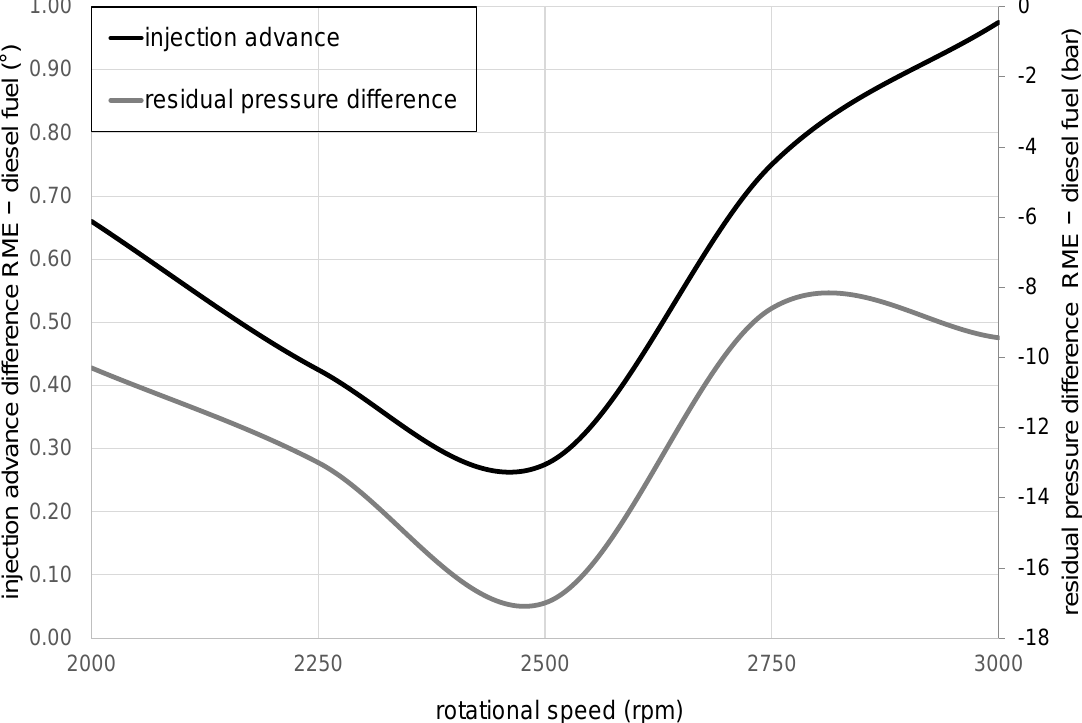
Figure 13. Injection advances with the RME and the diesel fuel and residual pressure difference between the same two fuels as a function of the engine speed and at full load.